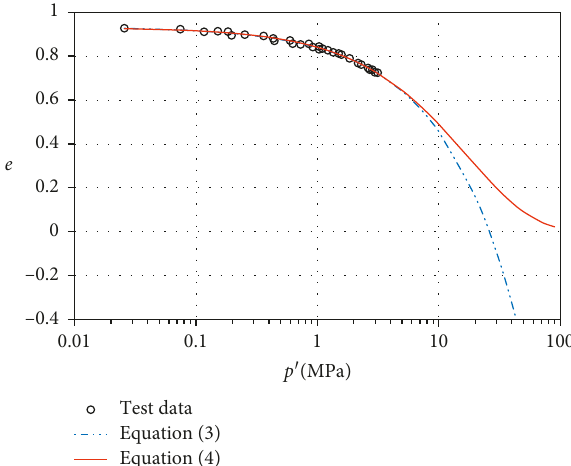
Figure 2: Comparison between critical state lines simulated by Equations (3) and